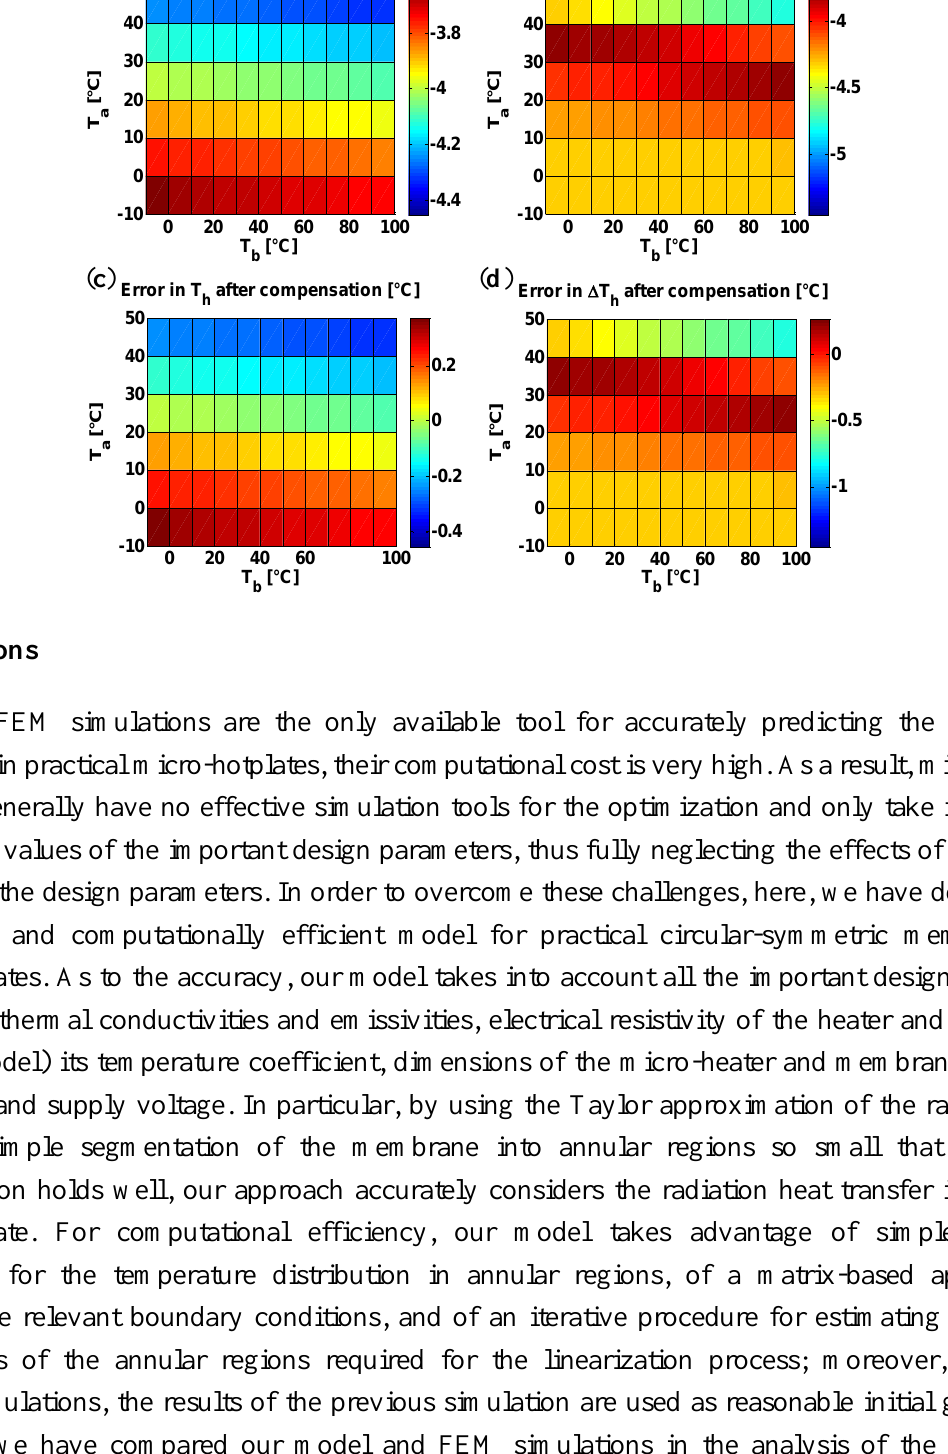
Figure 10. Error in model results ( a, b ) and error in model results after compensation by single FEM simulation ( c, d ) for the average temperature in hot region, T maximum temperature difference in hot region, Δ T